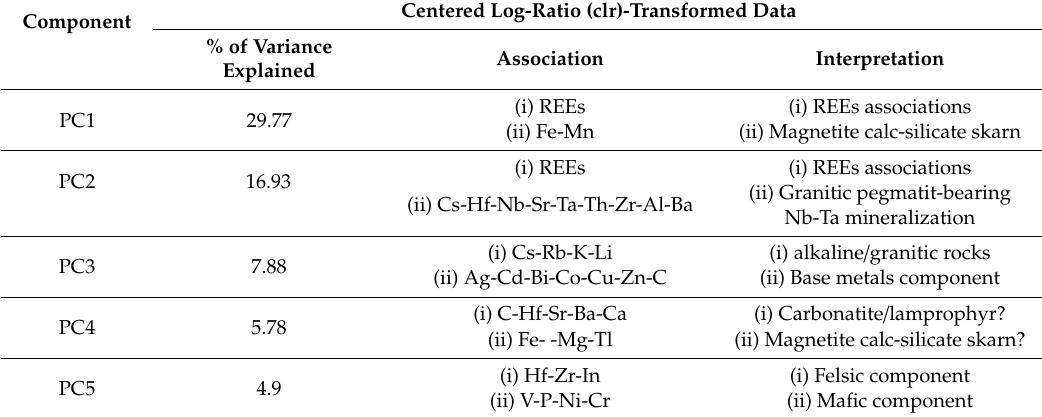
Table 3. Explanation of the five principal components for elements analyzed, accounting for 65% of the total variance.